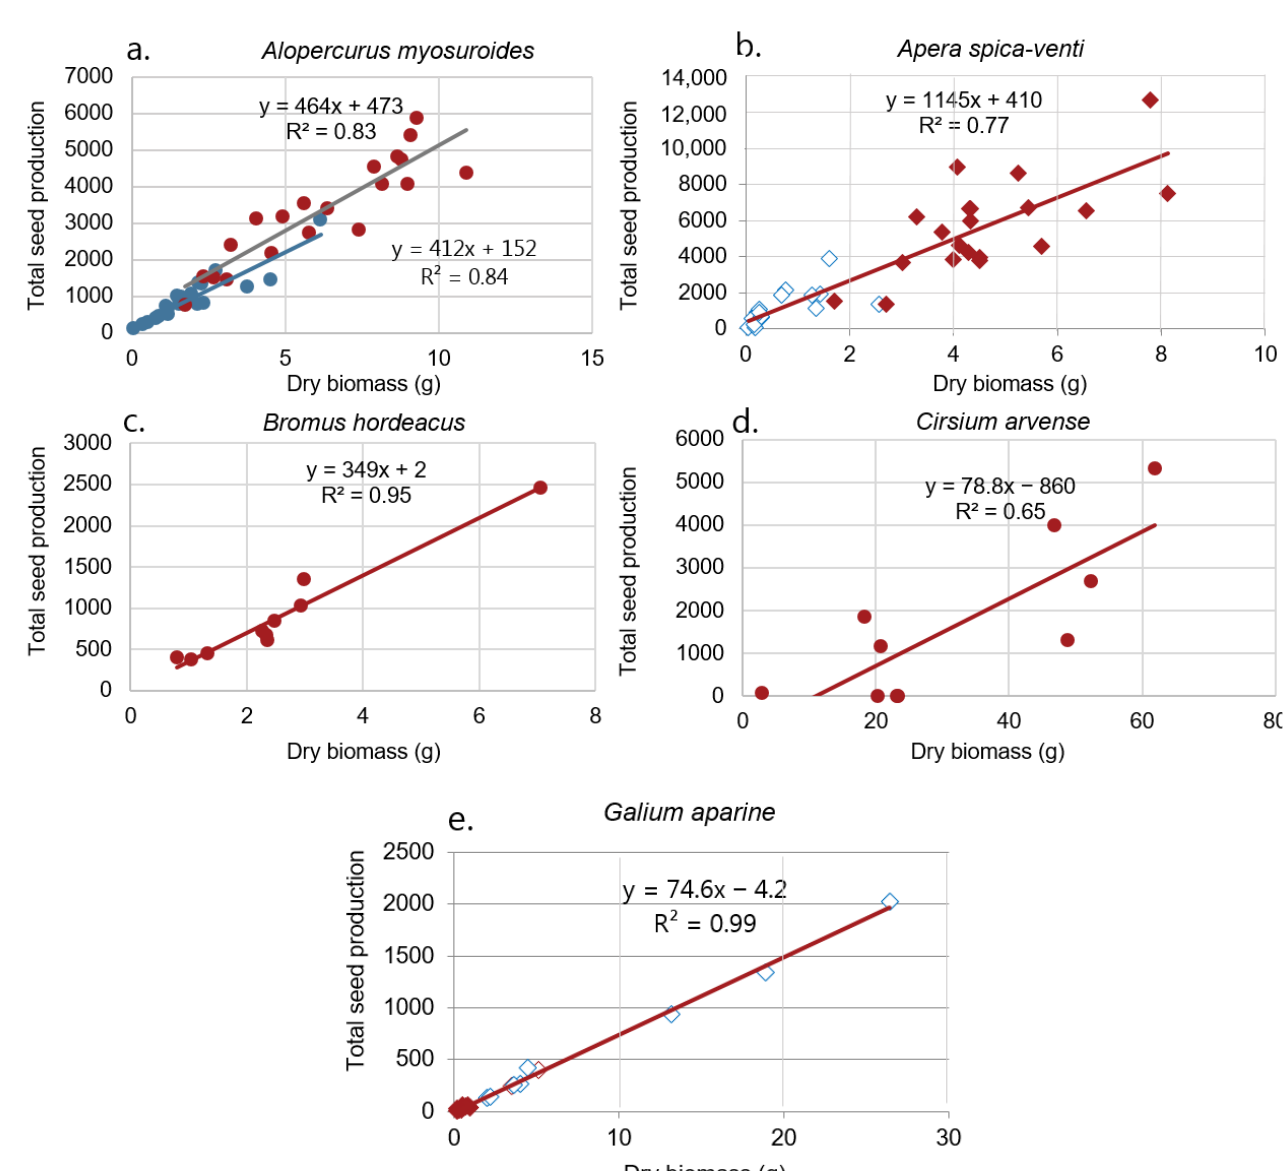
Figure 5. Relationship between plant dry weight and seed number per plant for ( a ) Alopecurus myosuroides , ( b ) Apera spica-venti , ( c ) Bromus hordeaceus , ( d ) Cirsium arvense, and ( e ) Galium aparine growing in two wheat fields. The red points correspond to observations in 2018 and the blue points correspond to observations in 2017. Regression lines are shown for both years. Where year did not affect the relationship significantly, the data from the two years were pooled together ( b , e ). Bromus hordeaceus was only observed in 2017 and C. arvense only produced seeds in 2018.